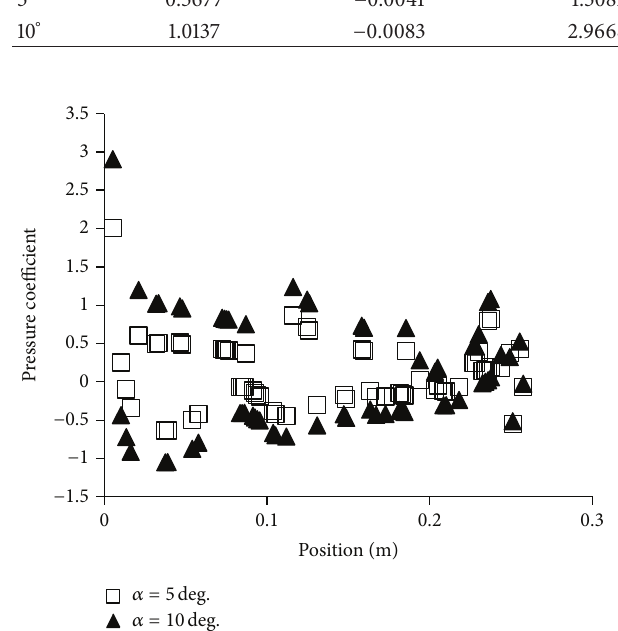
Figure 8: Pressure coefficients integrated over the rostrum surface, corresponding to 𝛼 = 5 ∘ and 𝛼 = 10 ∘